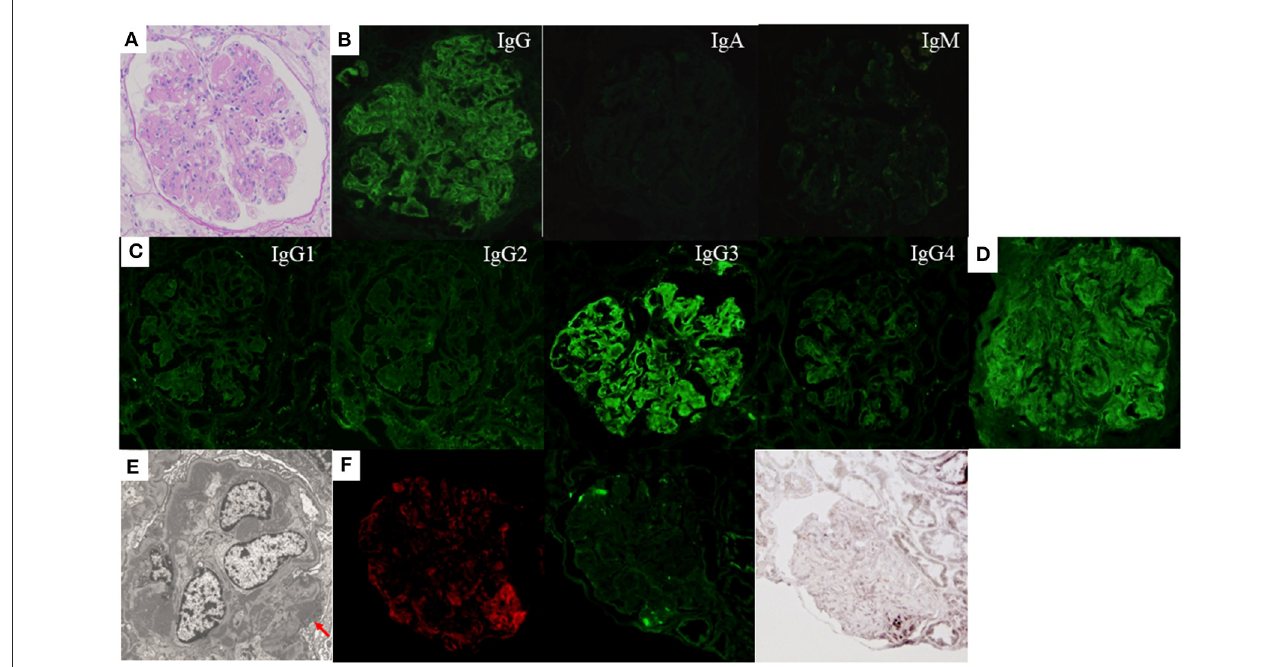
FIGURE2 Histological features of the first renal biopsy of case 2. Lobulation of a glomerulus accompanied by mesangial and endocapillary proliferation as well as thickening and double contour of capillary walls are shown by light microscopy [ (A) periodic acid-Schiff stain]. Immunofluorescence (IF) staining showed strong deposition of immunoglobulin (Ig) G mainly along the glomerular capillary walls. The deposition of IgA and IgM was negative (B) . IF staining for IgG subclasses demonstrates sole deposition of IgG3 (C) . Strong deposition of lambda-light chain is observed by IF staining (D) , which seems to correspond with electron-dense deposits in the mesangial and subendothelial areas shown by electron microscopy. There were also small amounts of subepithelial electron-dense deposits [ (E) red arrow]. Positive IF staining for complement C3 (left), nephritis-associated plasmin receptor (NAPlr, middle), and in situ zymography for plasmin activity (right) are shown in the glomerulus. The distribution of positive portion for C3 and NAPlr is different, but that for NAPlr and plasmin activity is similar (F) .